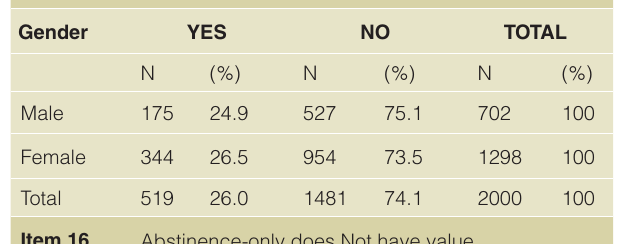
Table 10. Perspective of adolescents according to gender on the acceptance of abstinence-only sexual education. Abstinence-only sexual education provides some Item 15 information on STIs and contraception Gender YES NO TOTAL